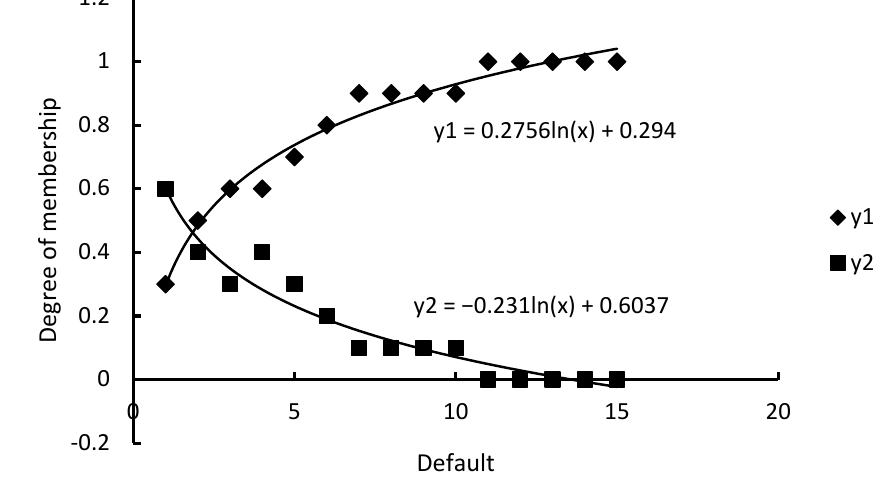
Figure A24. Single factor evaluation for the index of default (one and more times).